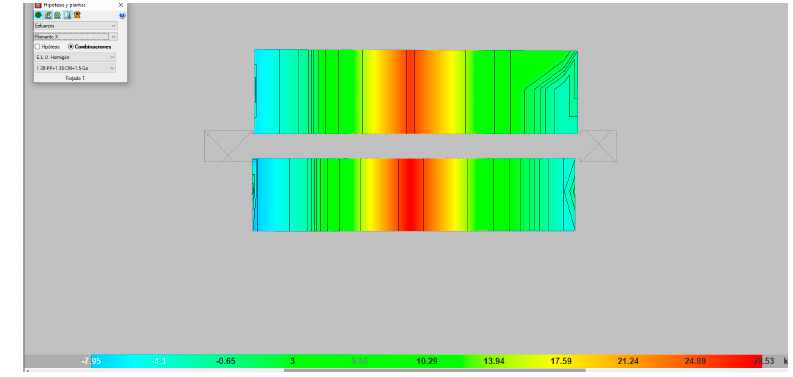
Figure 16. Deformation under the maximum load (mm).